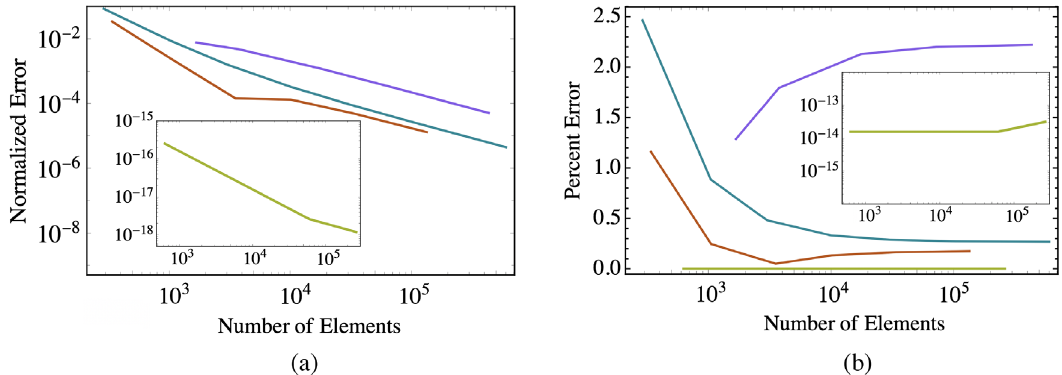
FIG. 3. Plots of the mean normalized error per element (a) and percent error in total surface area (b) for the sphere (blue line), cylinder (orange line), rectangular prism (green line), and ellipsoid (purple